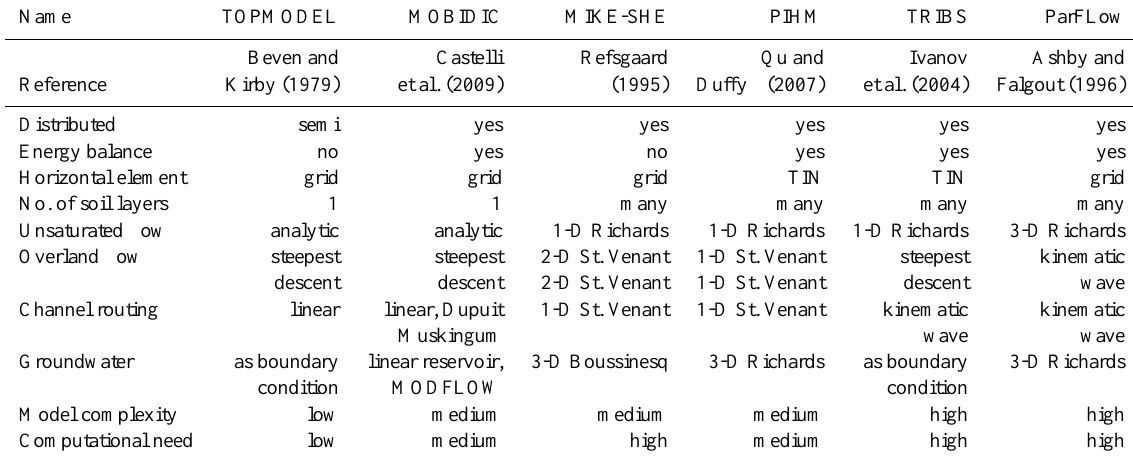
Table 1. Comparison of MOBIDIC with other hydrologic